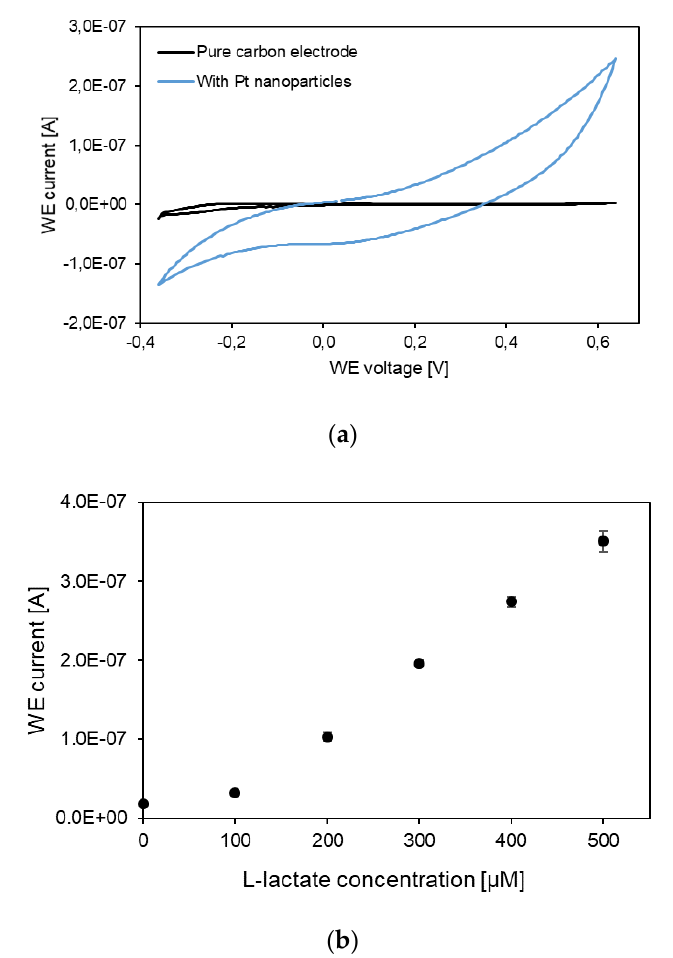
Figure 2. ( a ) Cyclic voltammetry in 50 μM H 2 O 2 , dissolved in PBS at a 25 mV/s scanning rate with a bare carbon electrode and a carbon electrode with electrodeposited Pt-NPs; ( b ) calibration curve of a L-lactate biosensor in PBS. The standard deviation was calculated using the response of ten biosensors.